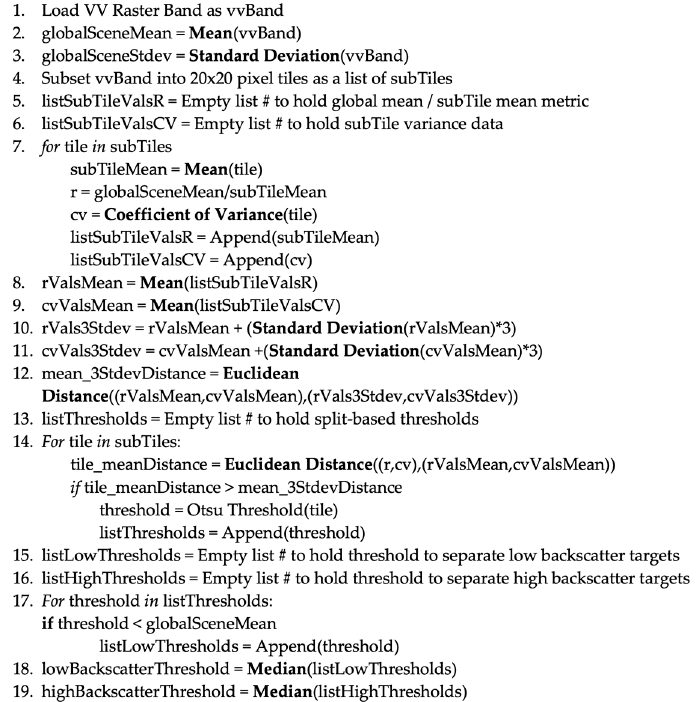
Figure 5. A pseudo-code description of Split-Based Thresholding approach used to generate global image thresholds.